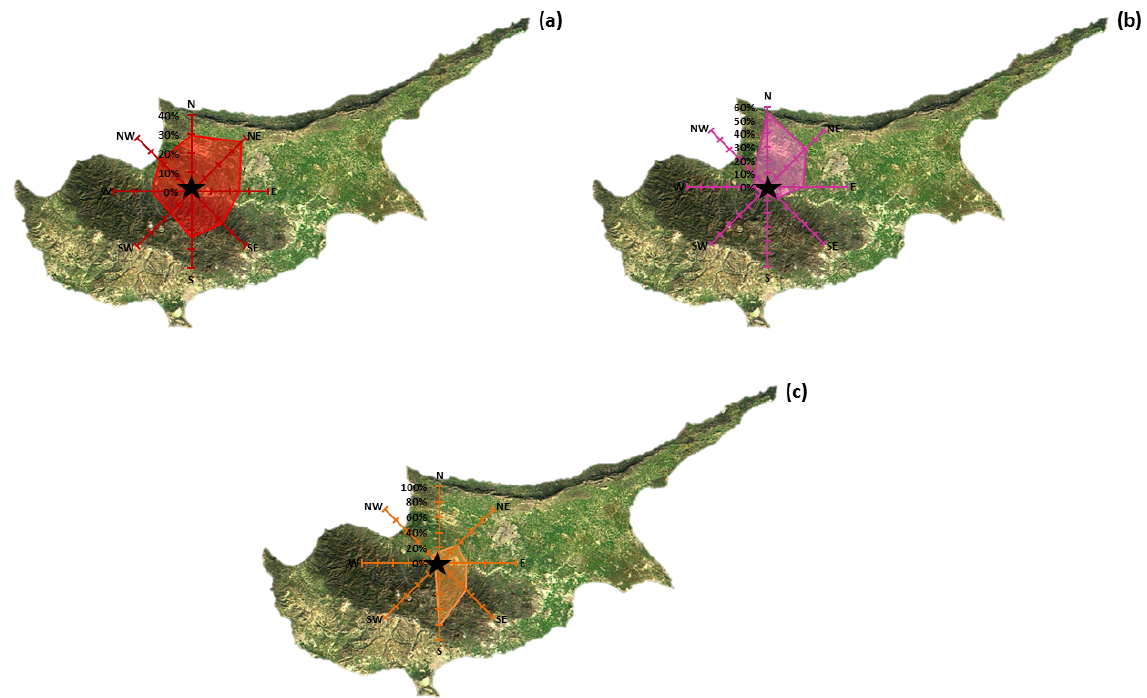
Figure 11. Rose of the CPF for VOC factors 3, 4, 5 ( a–c , respectively). CPF results do not include contributions obtained when the site was under the influence of air masses categorized as belonging to cluster